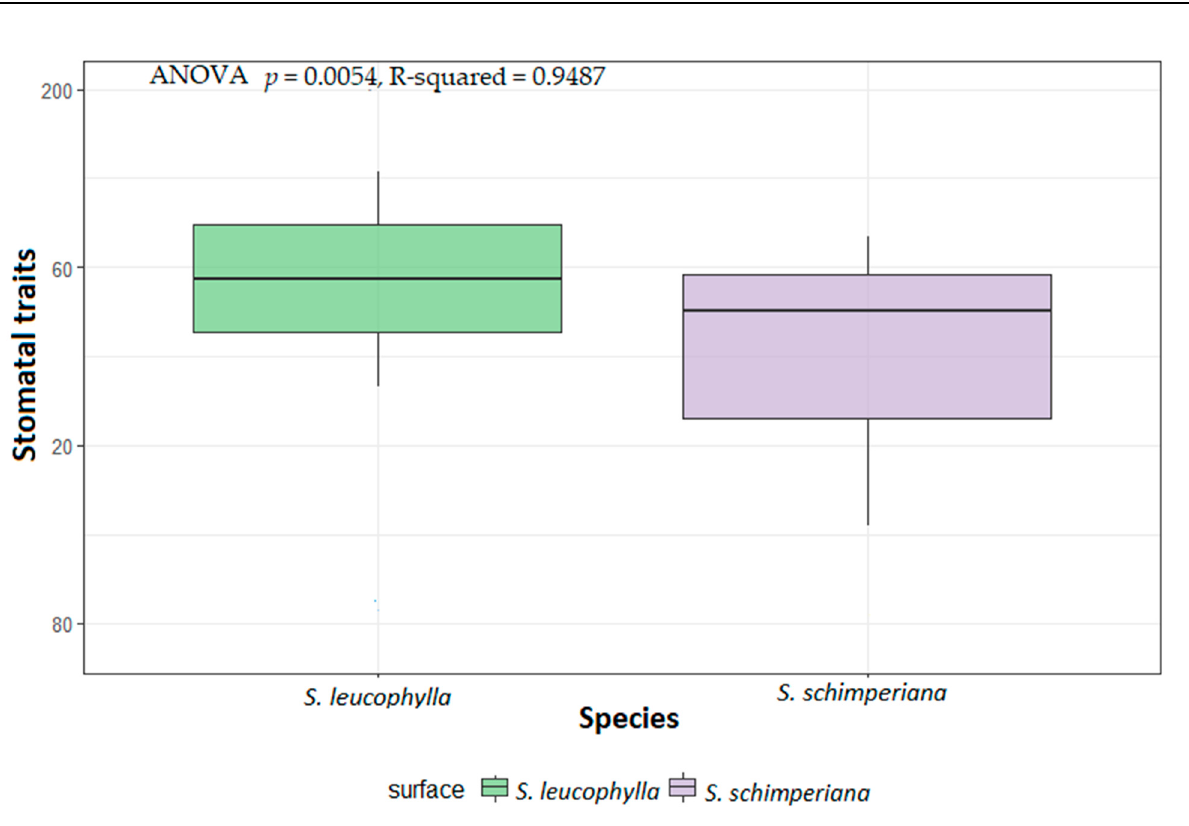
Figure 2. Boxplots of micromorphological stem stomatal traits of Silene leucophylla and Silene schimperiana .